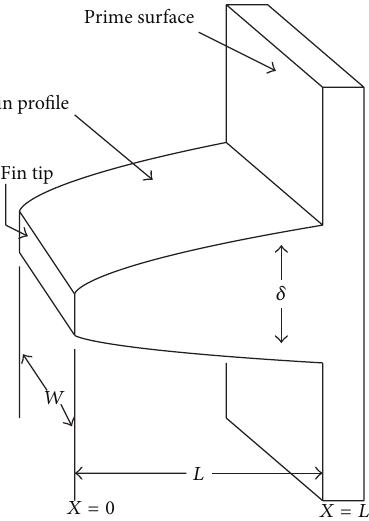
Figure 1: Schematic representation of a longitudinal fin of an arbitrary